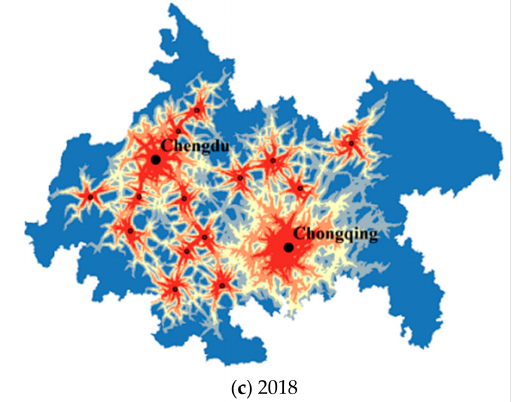
Figure 5. Overall field strength map of the CCUA.